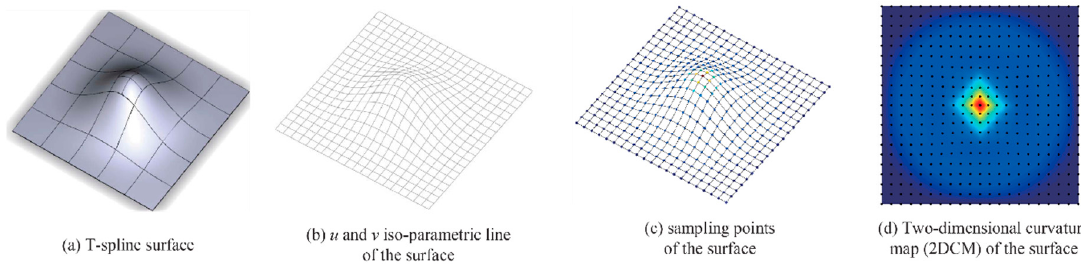
Figure 3. The two-dimensional curvature map (2DCM) of the T-spline surface.